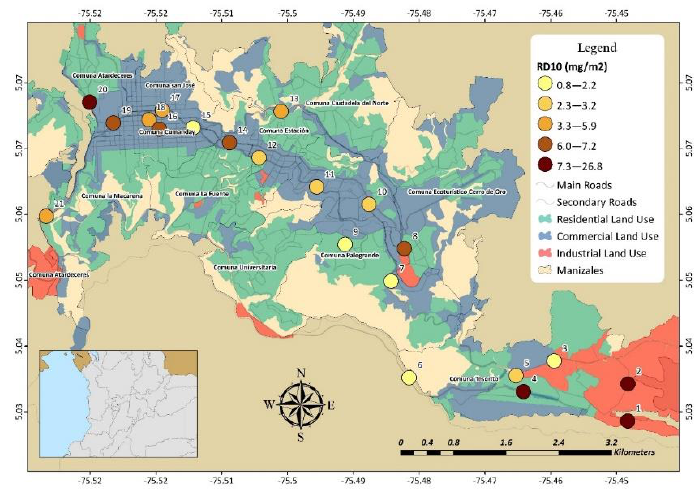
Figure 4. Spatial distribution of road dust loads in Manizales.